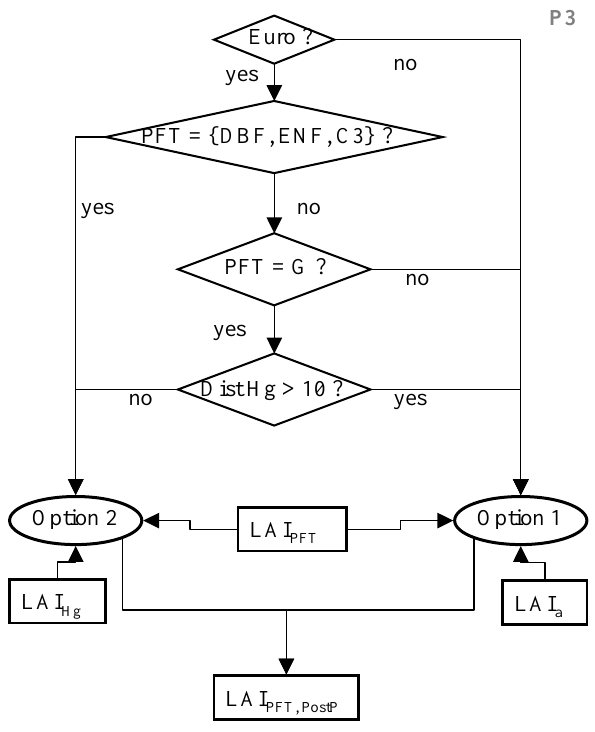
Fig. 16. Flowchart with post-processing steps of PFT derived LSA- SAF LAI, LAI PFT , to obtain a consistent LAI, LAI PFT,PostP . Op- tion 1 refer to the correction of the retrieved LAI with the pixel estimate, while option 2 points to the nearest homogeneous pixel as the reference